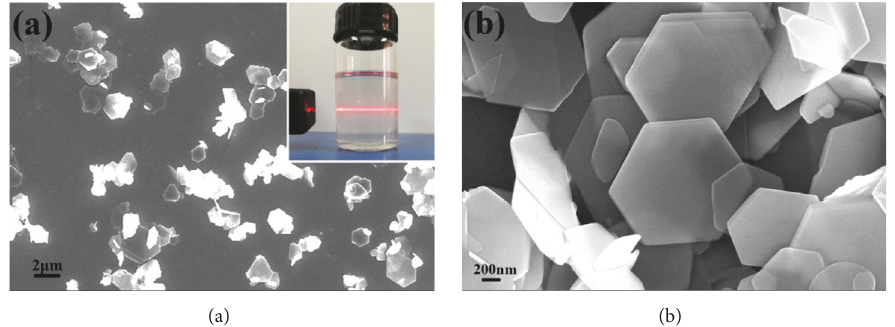
Figure 2: ((a), (b)) SEM images of the Bi 2 Se 3 nanoplates; the inserted picture in Figure 2(a) is the Bi 2 Se 3 suspension and the corresponding Tyndall effect.